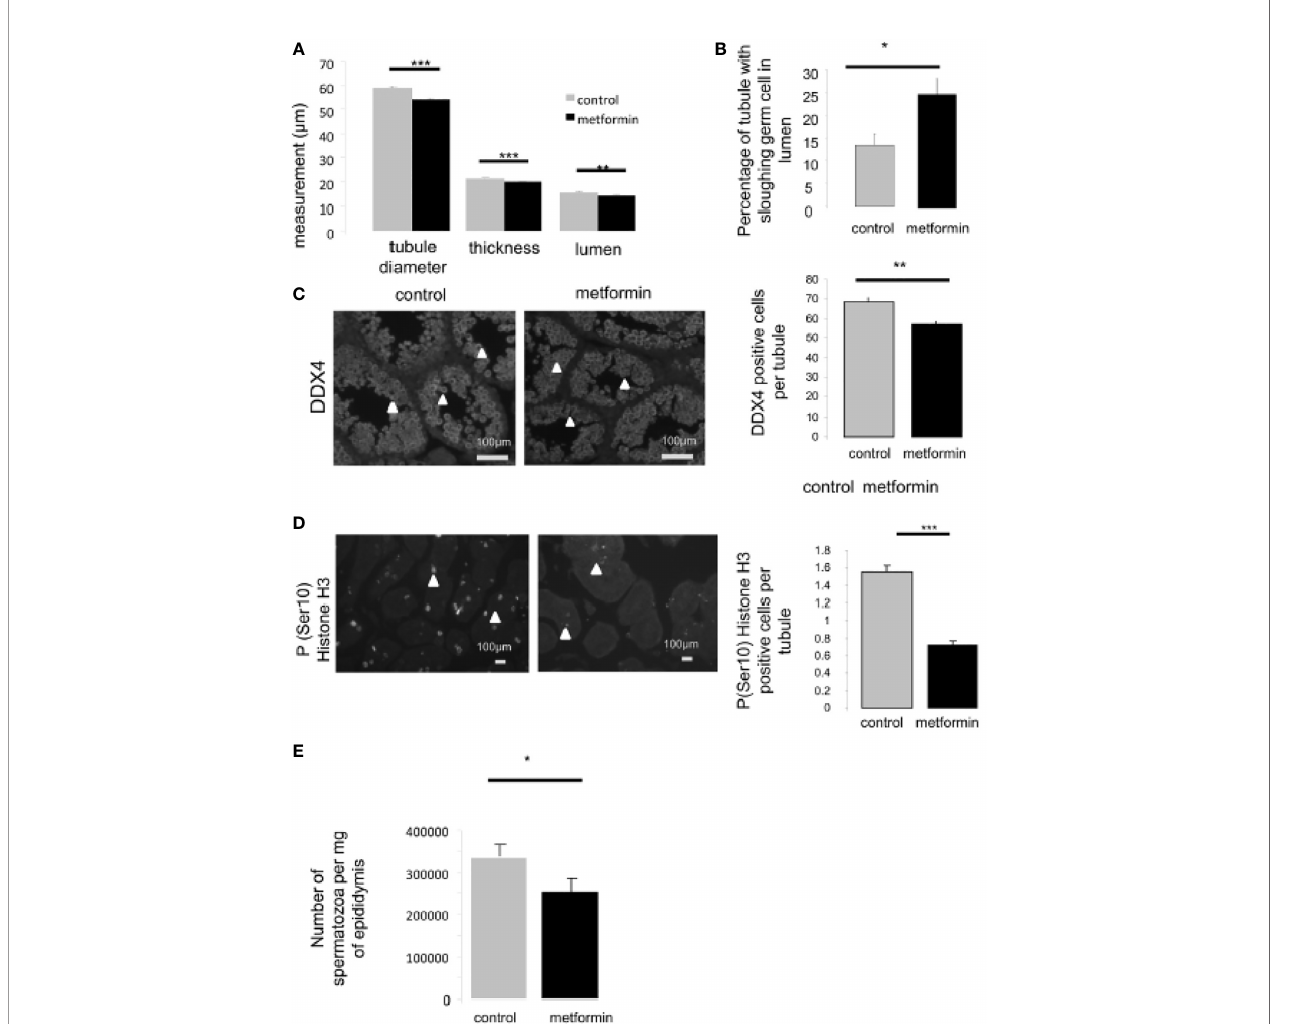
FIGURE 8 | Testis morphology of 25dpp old male mice. (A) Seminiferous tubule diameter, thickness of seminiferous epithelium and lumen diameter were measured on 50 round seminiferous tubules (n=4). (B) Quanti fi cation of tubule with sloughing germ cells in lumen, (n=5, 150 seminiferous tubule per individual were counted). (C) Number of germ cells was quanti fi ed by immunohistochemistry against DDX4, Scale bar: 100 µm, (D) and against phospho-Ser10-Histone H3 (proliferative cells), a minimal of 100 round seminiferous tubules per mice was counted, (n=4). Quanti fi cation of positive cell per round seminiferous tubule is shown on the left side of the micrograph (n=4); there were counted on 150 seminiferous tubules per individual. Scale bar= 100µm. White arrow indicates positive cell. (E) Spermatic head concentration in epididymis, normalized against epididymis weight (control male n=4 vs male exposed in utero n=7). *p < 0.05, **p < 0.01, ***p < 0.001.